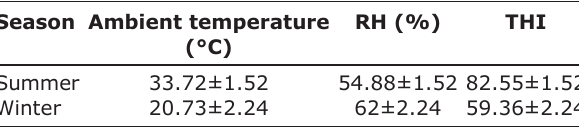
Table-1: Temperature, relative humidity and THI of the summer and winter